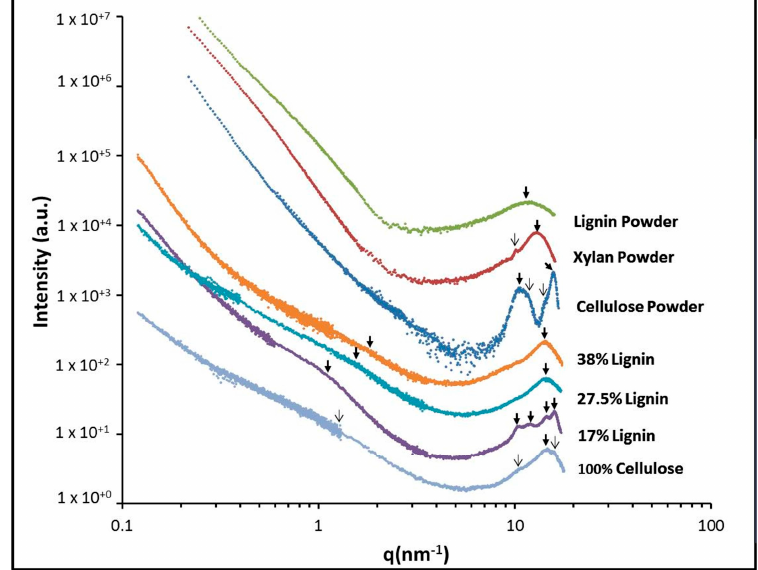
Figure 4. X-ray scattering profiles for the various samples. The intensity is offset to denote the difference between each sample. The arrows indicate the position of each scattering vector peak.